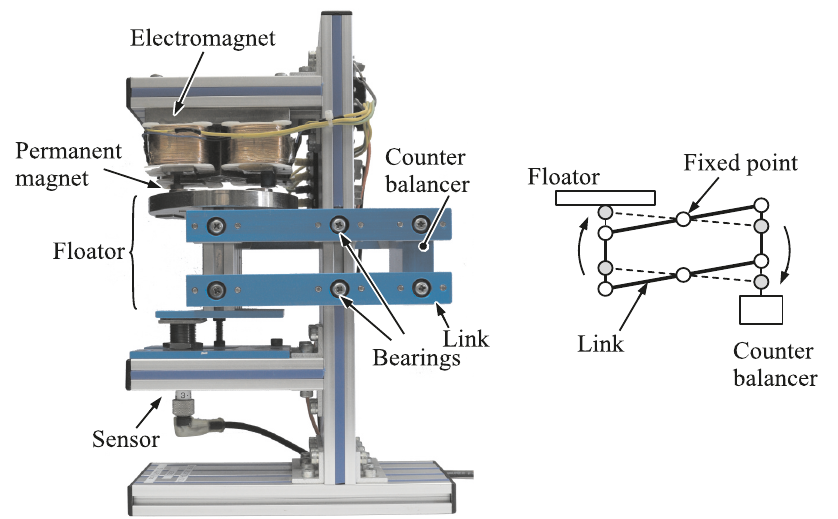
Figure 5. Photograph of magnetic suspension apparatus and schematic motion of the floator.